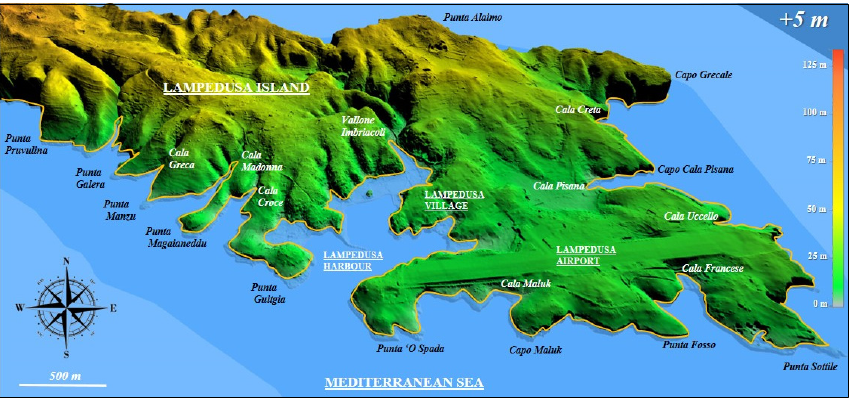
Figure 8. 3D flooding map (+5 m) along the southeastern sector of the island of Lampedusa.